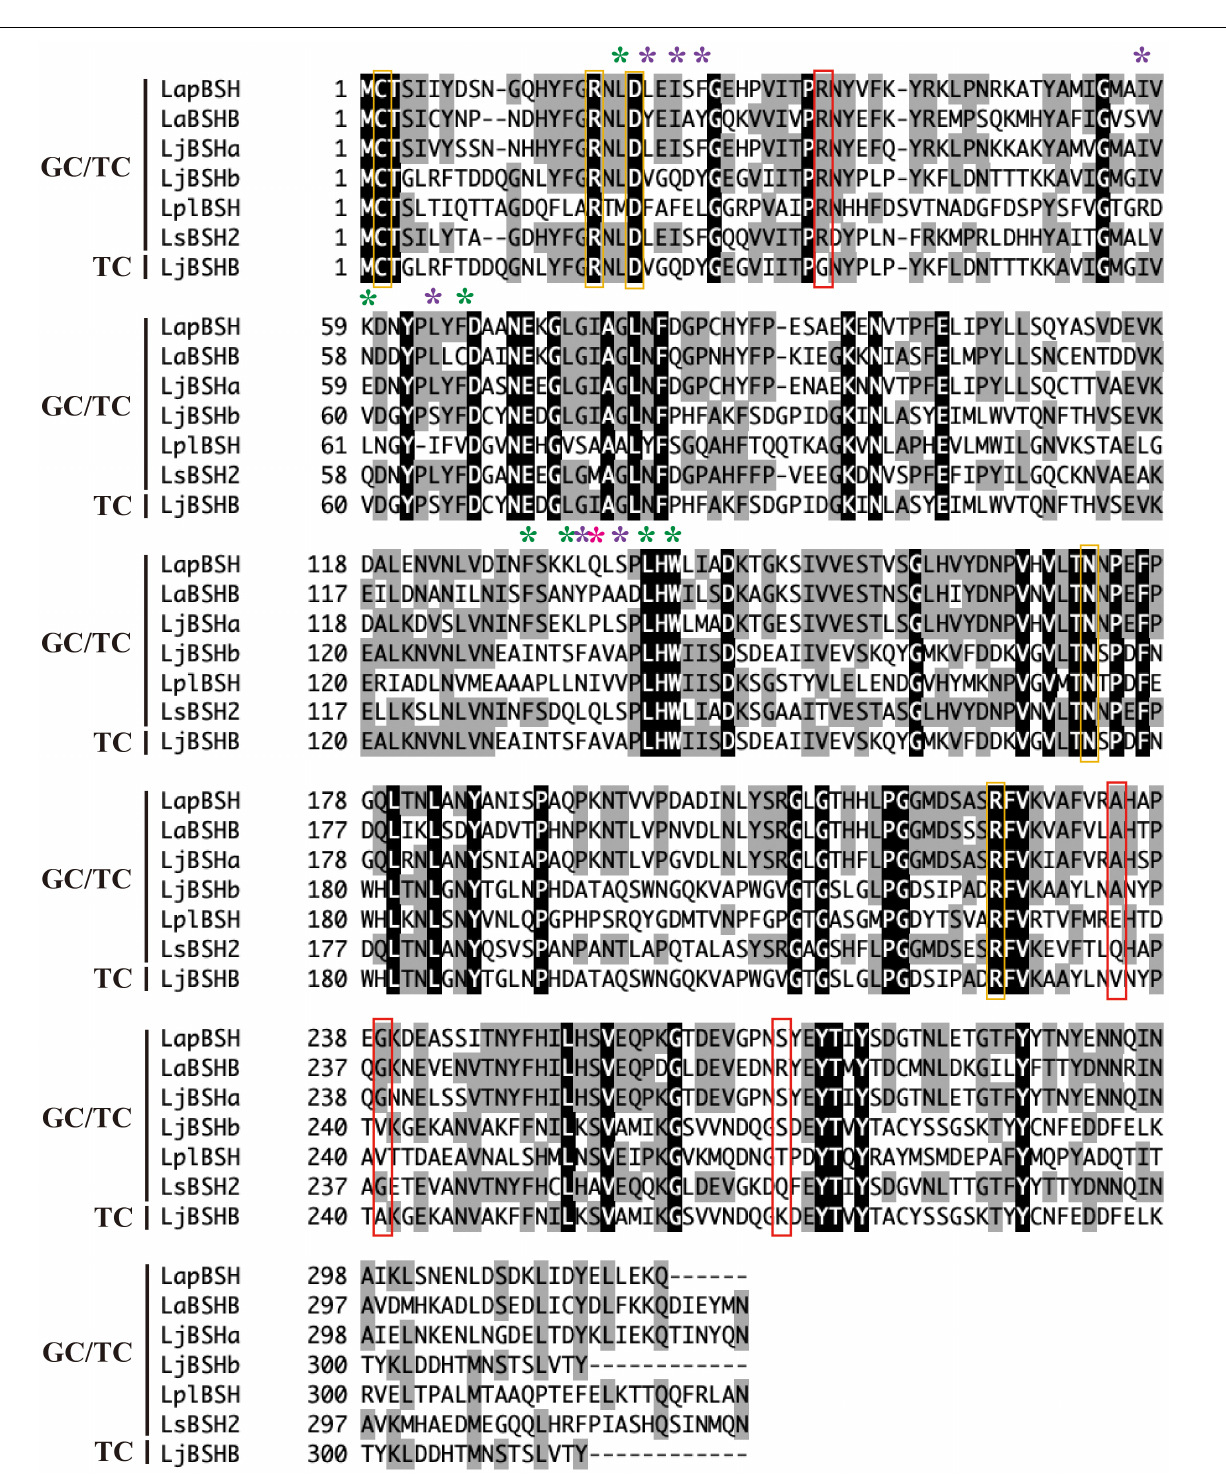
Frontiers in Microbiology |